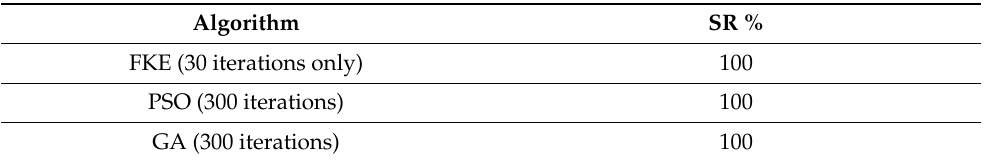
Table 9. The success rate (SR) of the proposed FKE algorithm, PSO, and GA for the anti-jamming smart antenna system (No. of runs = 30).